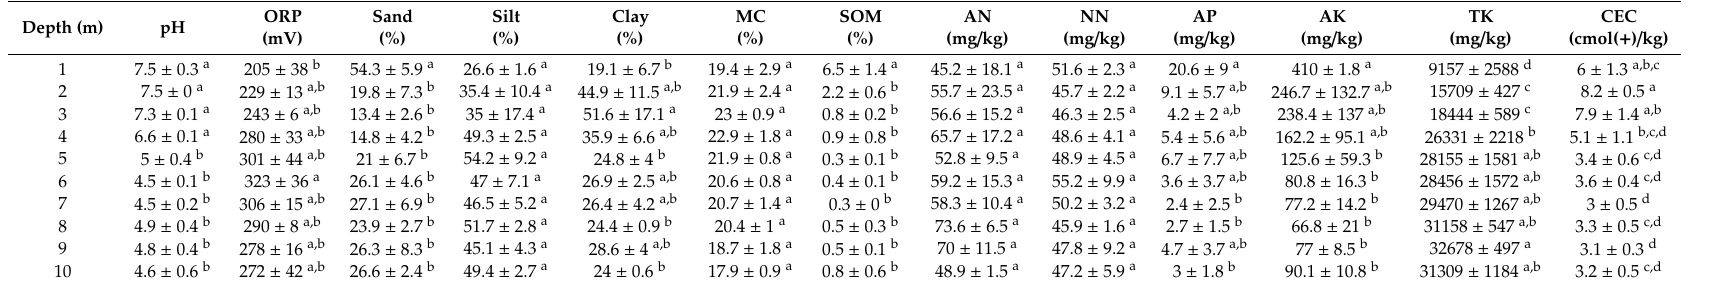
Table 1. Physicochemical properties of studied soil